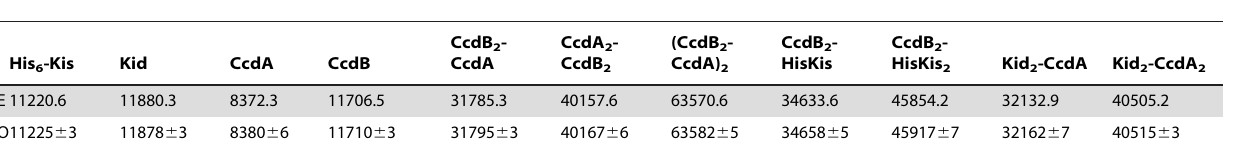
Molecular mass is expressed in Daltons. E: Theoretical molecular mass expected for a protein or